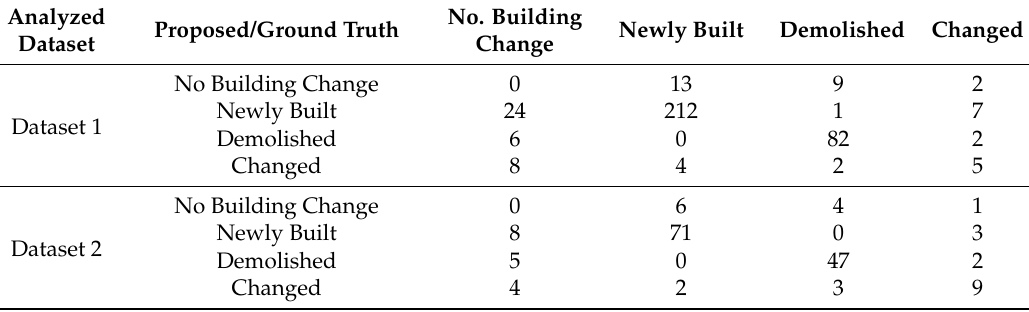
Figure 16. Corresponding results evaluations of the two datasets and enlarged subsets for ( a ) Dataset 1 and ( b ) Dataset 2. Table 2. Confusion matrix of the building change detection.